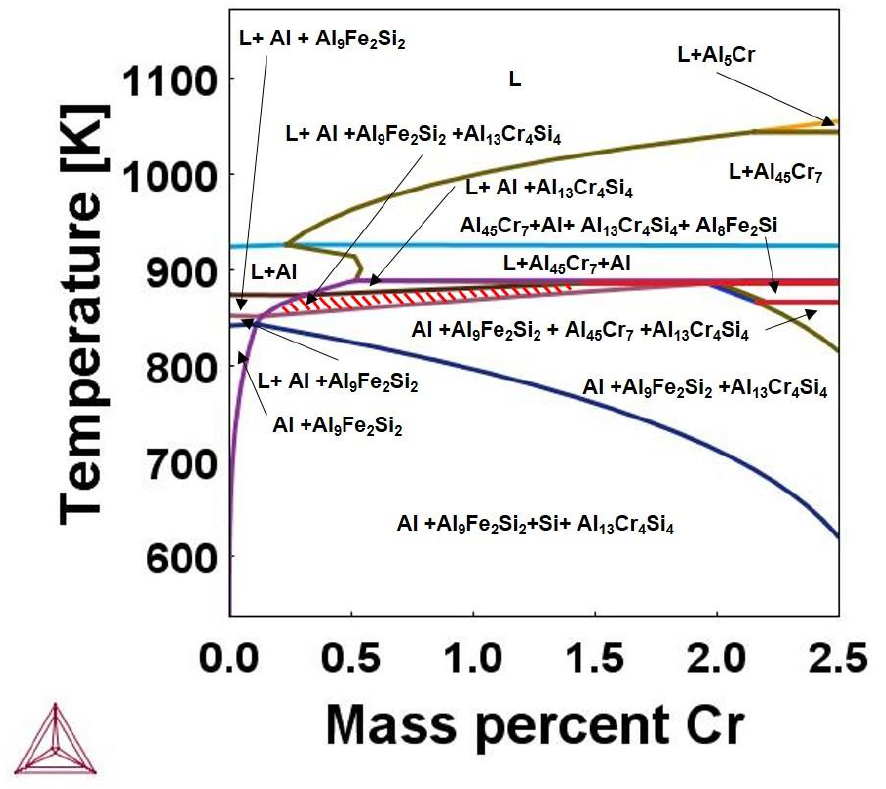
Figure 15. Al-Si-Fe-Cr phase diagram at fixed concentrations of 1.5% of Si and 0.1% of Fe. When the melt temperature during mechanical stirring was high and its duration was long, CrSi 2 particles had time to dissolve in the melt, and then, when the melt was cooled down, Al 9 Fe 2 Si 2 and Al 13 Cr 4 Si 4 compounds coexisted with liquid and solid alumi- num within a narrow temperature range, as shown in Figure 15 by the hatched area. As the solidification of liquid aluminum and the formation of these compounds proceeds simultaneously, they were pushed to the aluminum grain boundaries, as can be seen from Figure 9. On the other hand, when the melt temperature was comparatively low and the duration of mechanical stirring was relatively short, some of the particles could remain in their original form or transformed partly into Al-Cr compounds. In this case, the concen- tration of Cr near such particles was high and, as seen in Figure 15, iron could only enter the particles through a solid-state transformation. This is why we observed the presence of iron in CrSi 2 particles in small amounts, as shown in Figure 14. 5. Conclusions In the present work, the fabrication process of master alloys by adding CrSi 2 particles into molten aluminum was investigated. The master alloys were designed to use it for the modification of Fe-containing intermetallic compounds in aluminum alloys with a higher concentration of iron. CrSi 2 particles were synthesized by ball milling and then added onto the surface of a vortex formed during the mechanical agitation of an aluminum melt. Fac- tors influencing the particle synthesis performance, the incorporation efficiency into the melt and the morphology of intermetallic compounds in the fabricated master alloys were considered, with the main emphasis being placed on dissolution mechanisms when CrSi 2 particles entered the Al melt. Based on the above results and discussion, the following conclusions can be drawn from this study: